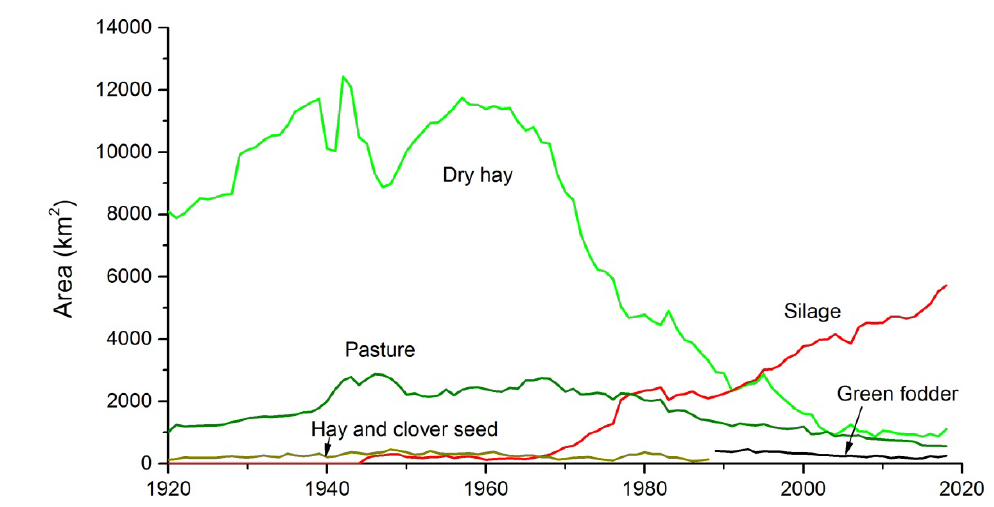
Fig. 2. Cultivation of grass crops in Finland in 1920—2018 (based on farm statistics of Natural Resources Institute Finland 2019c). The statistical record combines green fodder and hay and clover seed cultivation into green fodder starting from